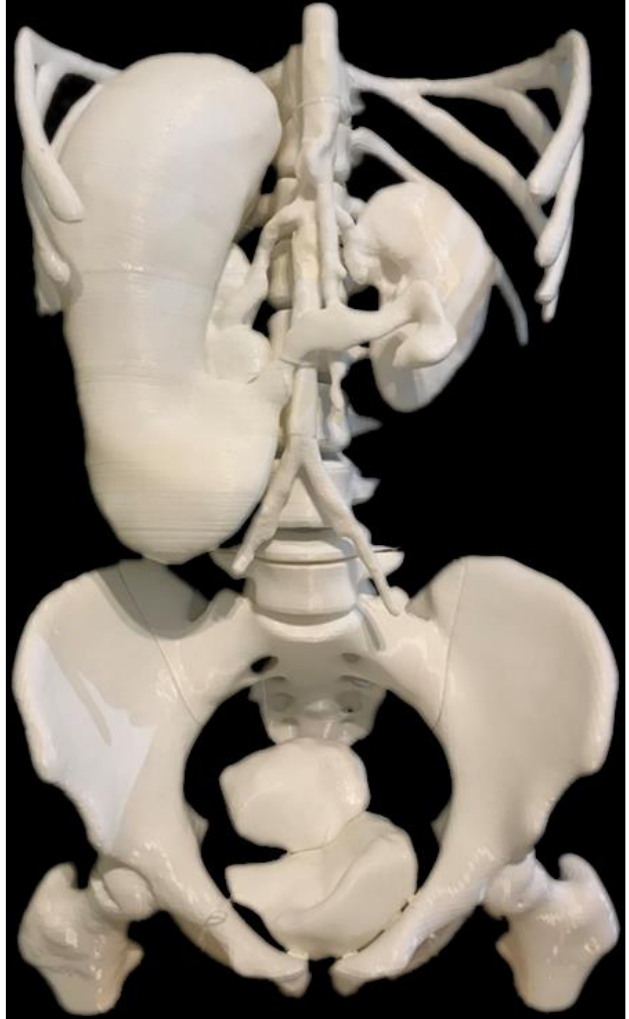
Figure 24. Demonstration of 3D-printed models of abdominal organs after being assembled together. Reprinted with permission from Etherton et al. [88].